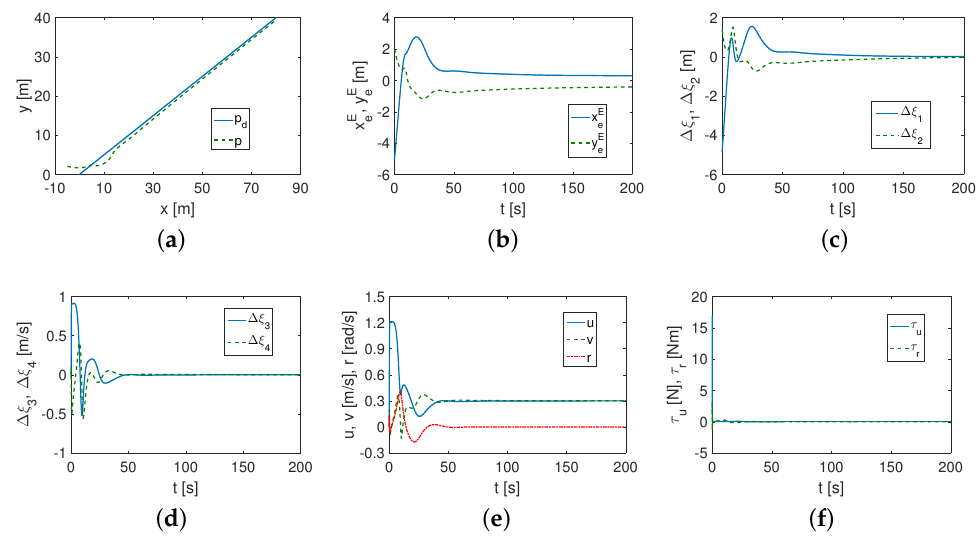
Figure 10. Simulation results for SIRENE, CL controller and linear trajectory: ( a ) desired and realized trajectory; ( b ) position errors; ( c ) position error states; ( d ) velocity error states; ( e ) velocities; ( f ) applied force and torque.